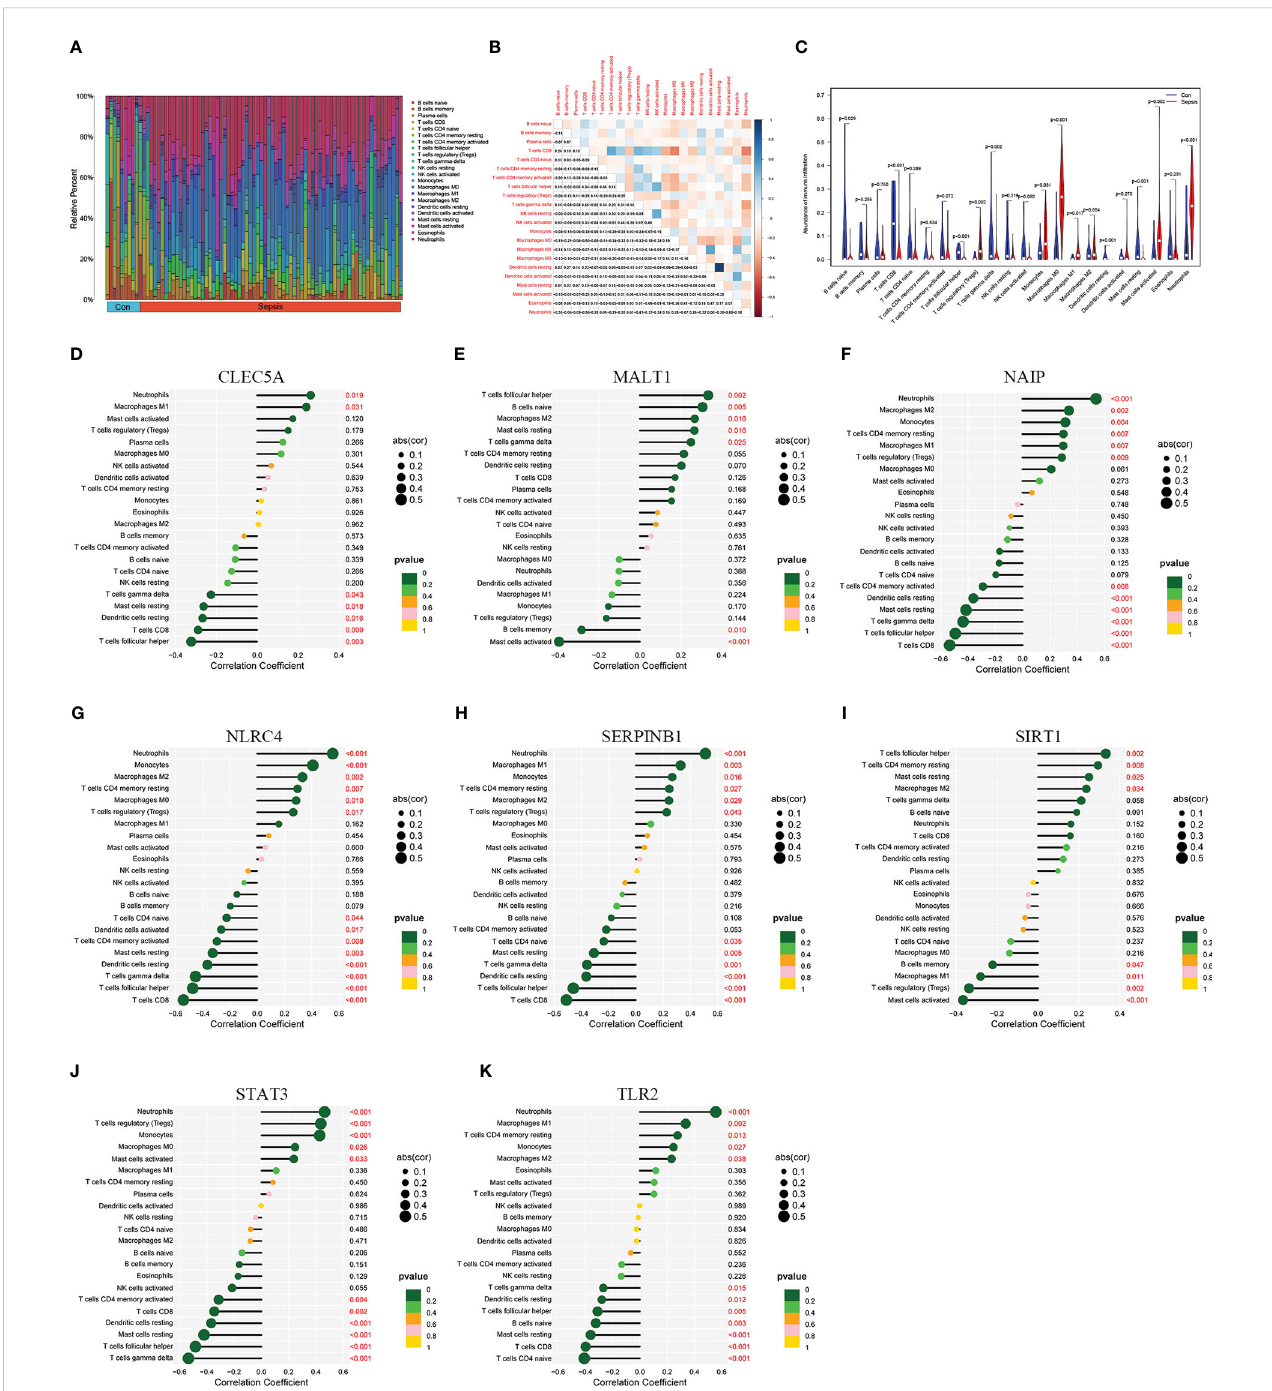
FIGURE 7 Immune in fi ltration landscape in sepsis and healthy controls. (A) is a bar graph of the proportions of 22 immune cells in sepsis and controls. (B) is a heatmap of correlations among 22 immune cells. (C) shows the differential expression of different immune cell in fi ltration abundance in sepsis and control. (D – K) are lollipop plots of CLEC5A, MALT1, NAIP, NLRC4, SERPINB1, SIRT1, STAT3, and TLR2 correlations with immune cells,